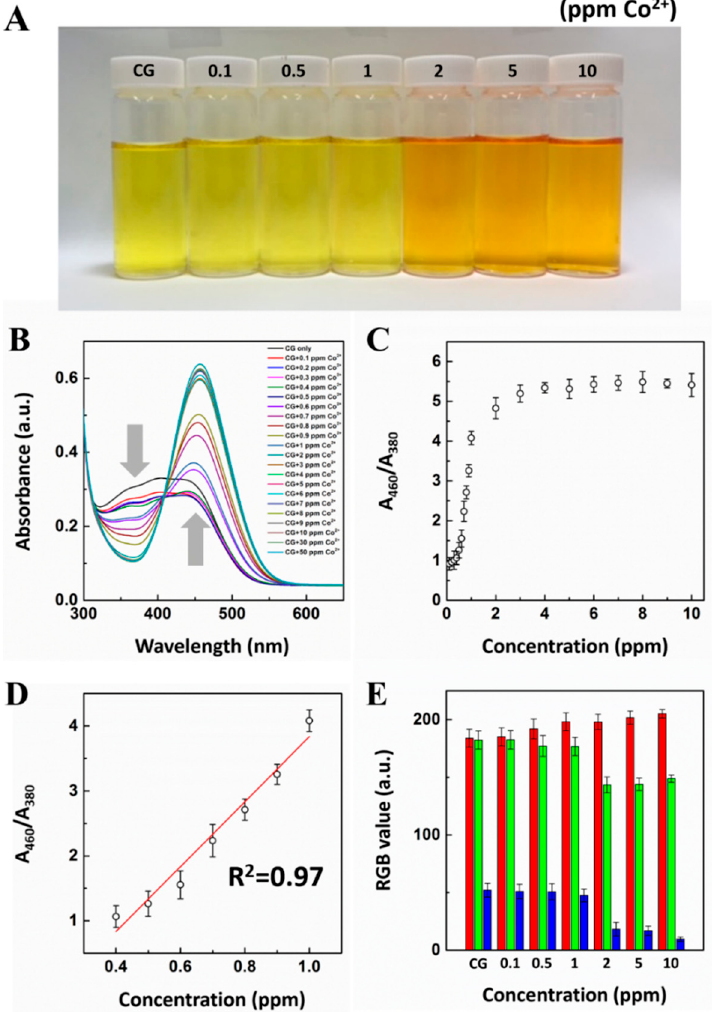
Figure 5. Colorimetric titration of cobalt. ( A ) Photographs for the color change of CG chemosensor to the concentrations of cobalt; ( B ) UV-vis absorbance changes of CG chemosensor in the presence of a serial concentration of the cobalt; ( C ) Intensity ratio (A 460 /A 380 ) versus the different concentrations of cobalt ion added; ( D ) Linear plot of cobalt concentration based on UV-vis absorbance analysis; ( E ) Quantitative analysis for RGB color profile of CG-Co 2+ complexationss. The concentration of CG chemosensor and cobalt are 7 × 10 − 5 M and 2 ppm, respectively.